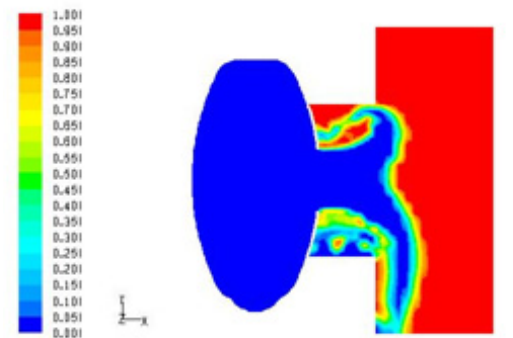
Fig. 2-6. Phase interface, high pressure difference, 0.35 s after start (model